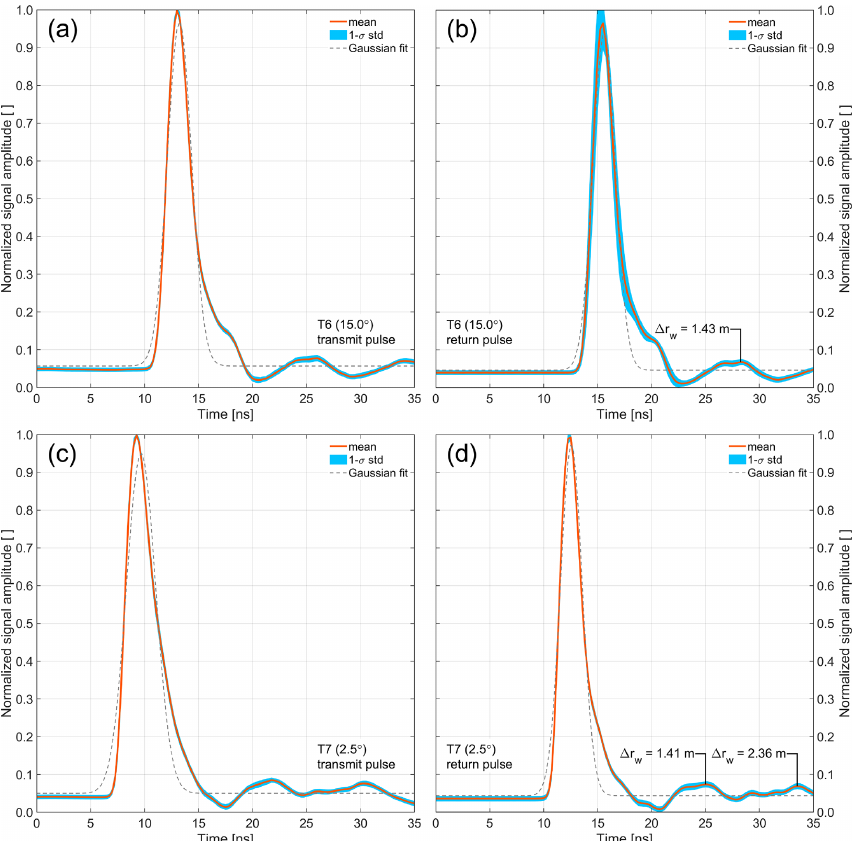
Figure A2. Averaged, normalized, unsaturated transmit and return waveforms of the T6 (a, b) and T7 (c, d) transceivers acquired over the airport ramp in Kangerlussuaq, Greenland, on 13 May 2019. The impact of surface slope and surface roughness of the ramp’s concrete surface within an ATM laser footprint does not contribute to the shape of the return waveform and can be neglected. The concrete surface has no subsurface penetration for 532nm laser light. The main peak is followed by smaller artifact peaks, the first of which occurs 12.75ns after the main peak in T6 and 12.5ns in the T7 waveforms. The difference between T6 and T7 corresponds to one sample for a digitization rate of 4GHz (0.25ns). The second peak in T7 occurs 21ns after the surface return. The corresponding slant range in water is (cid:49)r w . All three peaks have an amplitude of 7% of the surface return. A total of 28084 waveforms were stacked for T6, and 48703 waveforms were stacked for T7. The deviation from a Gaussian shape is the combined result of characteristics of the laser, photomultiplier detectors, and various other system components such as optical delay fibers and are common in waveform data of airborne and spaceborne lidars (Fig. A3).